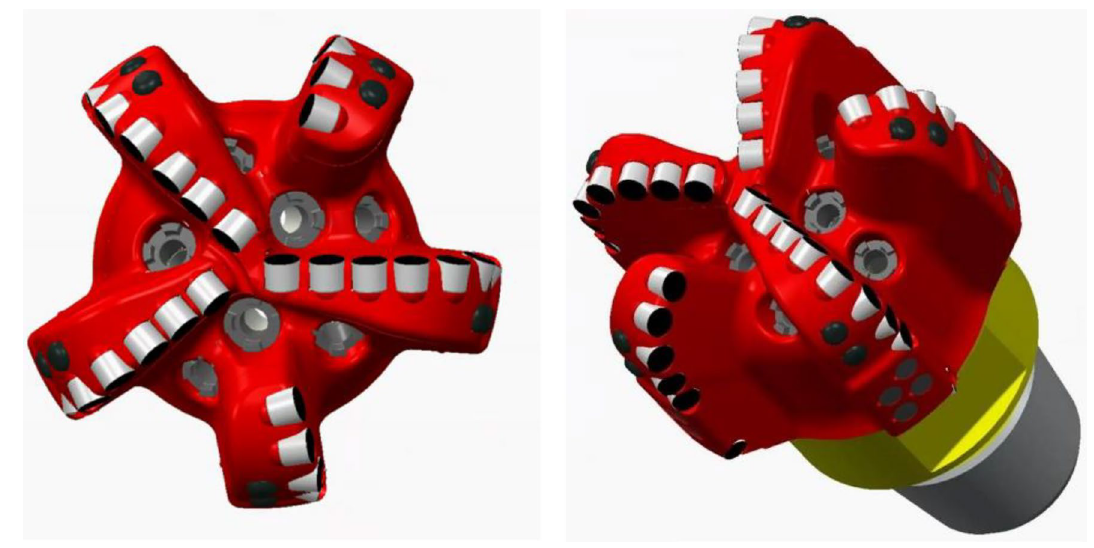
Fig. 20 3D model of the drill Bit